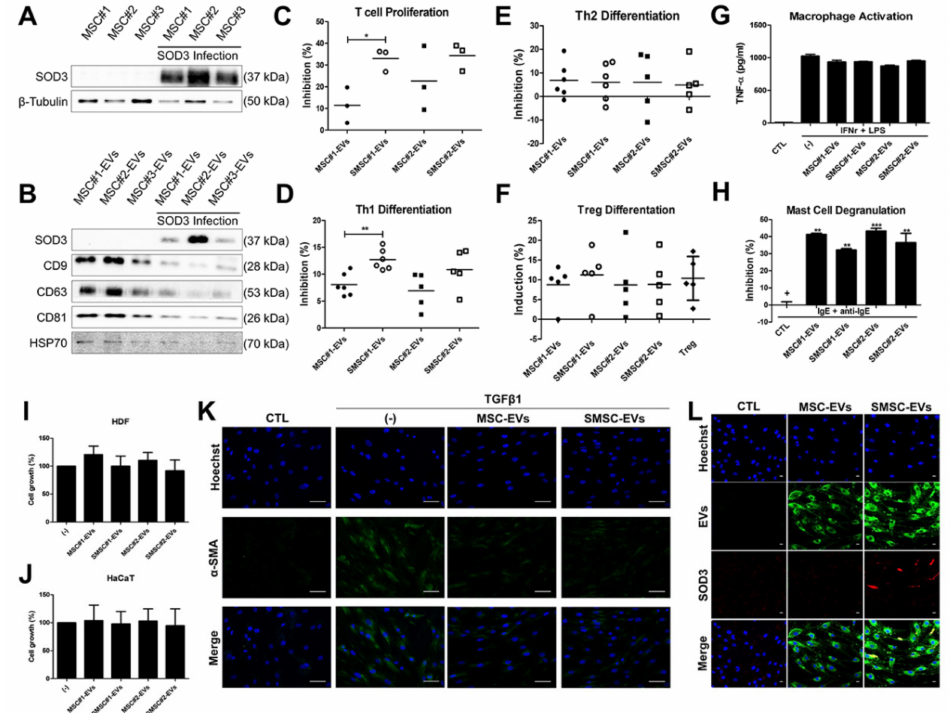
Figure 7. Immunoregulatory and anti-fibrotic features of extracellular vesicles (EVs) from MSCs. ( A ) Detection of SOD3 protein in SOD3-transduced MSC#1, MSC#2, and MSC#3 (at 48 h, 5 MOI) by immunoblotting. ( B ) Expression of SOD3 protein and EV markers (CD9, 63, 81, and HSP70) in SOD3-MSC-derived EVs. ( C ) T-cell-proliferation assay. ( D – F ) Representative dot plots and accumulated values showing the changes in percentages of Th1 ( D ), Th2 ( E ), and Treg ( F ) cells in CD4 + T cells treated with EVs. ( G ) THP-1 derived macrophages were activated and TNF- α production in the absence or presence of EVs was detected by ELISA. ( H ) β -hexosaminidase levels released into the culture media were measured by ELISA. ( I,J ) CCK-8 assay for HDF and HaCaT-cell proliferation after EV treatment for 24 h. ( K ) Myofibroblast di ff erentiation and its inhibition by EV treatment were determined by α -SMA staining. Scale bar = 100 µ m. ( L ) HDFs were incubated with EVs for 24 h and EV uptake (green) and SOD3 protein delivery (red) were detected by confocal microscopy. Scale bar = 20 µ m. Results are shown as mean ± SD. *, ** and *** represent p < 0.05, p < 0.01 and p < 0.001, respectively. p -value significance was calculated by comparing other groups against the ( + ) group (marked as + ). • : MSC#1, : SOD3-MSC#1, (cid:4) : MSC#2 and (cid:3) :